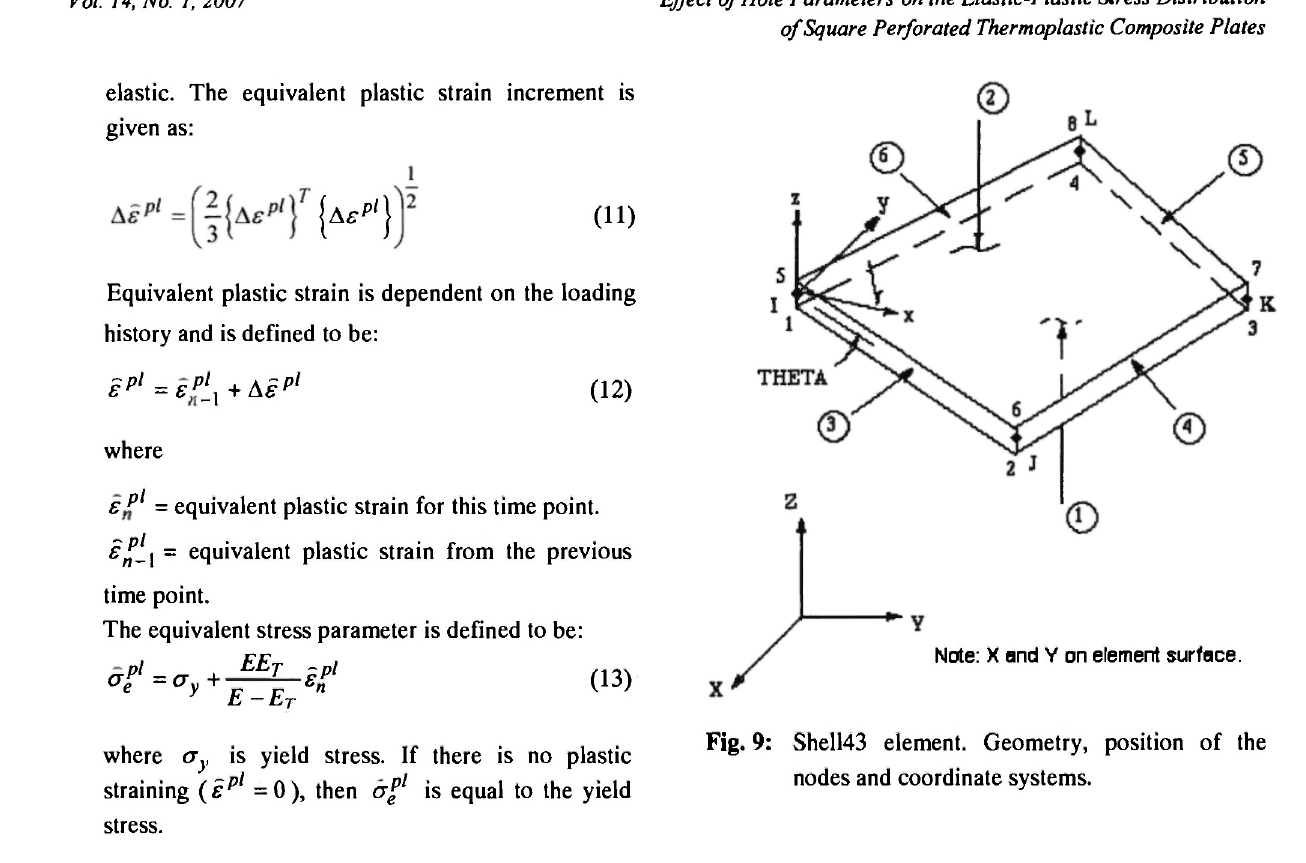
Fig. 9: Shell43 element. Geometry, position of the nodes and coordinate